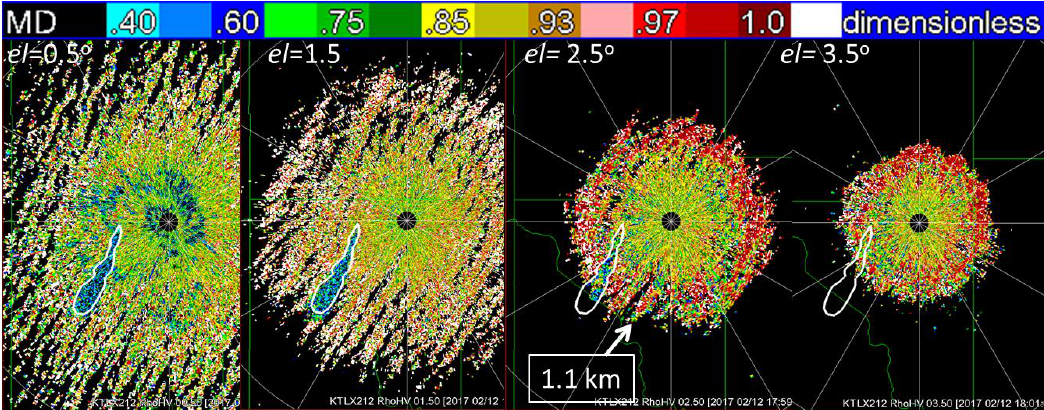
Figure 3. Fields of correlation coe ffi cient ρ hv at consecutive scans in elevations of the WSR-88D. The color bar indicates value categories. Date is February 12,